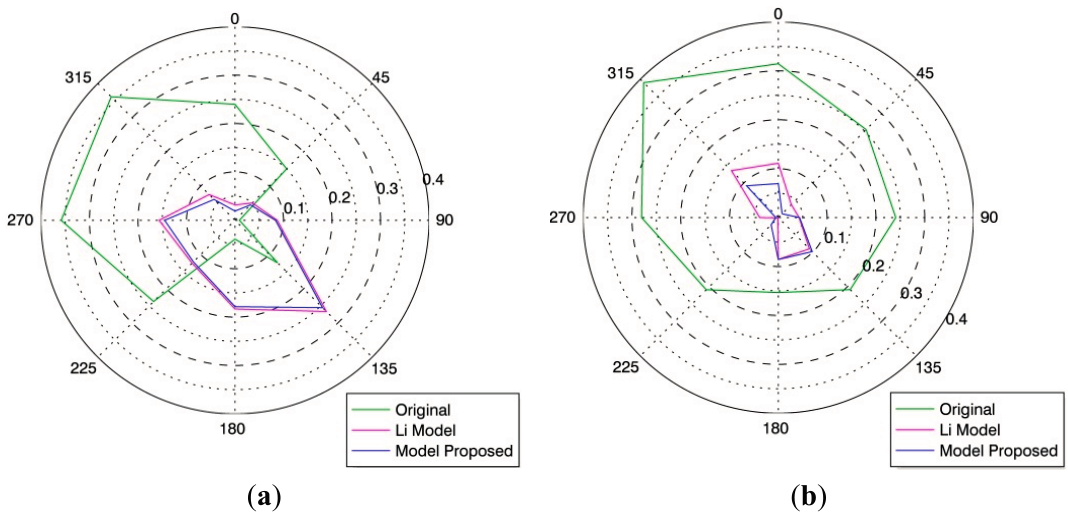
Figure 7. Correlation coefficients between reflectance and illumination condition for different aspect intervals before and after topographic correction; ( a ) is for the whole spring scene; and ( b ) for forest in spring